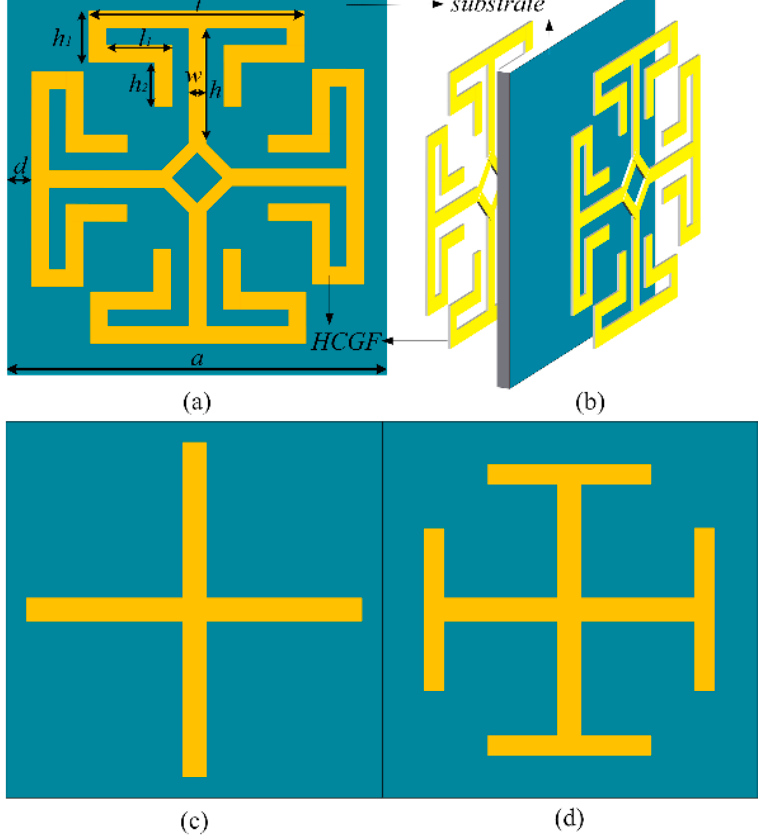
Figure 1. Unit cell configurations. ( a ) Proposed frequency-selective surface (FSS). ( b ) Proposed FSS made by high-conductivity graphene assemble film (HCGF) element configuration. ( c ) Cross FSS. ( d ) Jerusalem cross FSS. a = 10 mm, d = 0.3 mm, l = 7 mm, h = 2.7 mm, w = 0.3 mm, h 1 = 0.9 mm, l 1 = 2.75 mm, t = 0.03 mm.